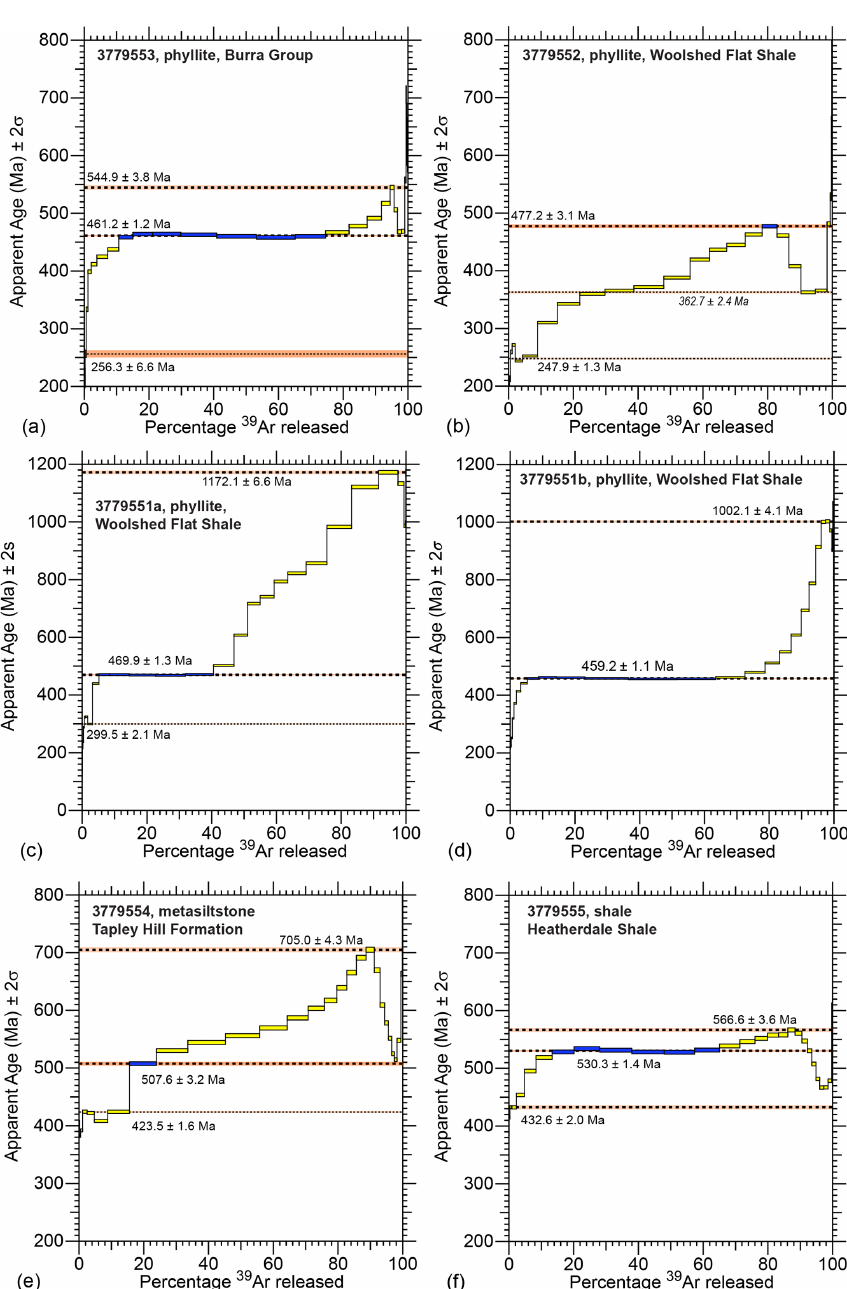
Figure 5. Apparent age spectra for samples analysed in this study. Age limits and asymptote (italicised in sample 3779552) defined using criteria of Forster and Lister (2004). All data tables are given in Reid and Forster (2022). (a) Sample 3779553. (b) Sample